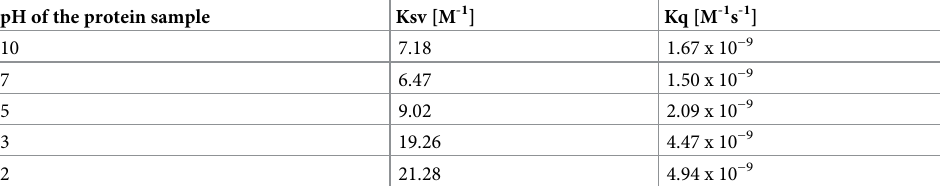
Table 2. Fluorescence quenching of Sus1 in presence of acrylamide at different pH states. The ratio of FI in the absence and presence of acrylamide at different concentration was plotted with the acrylamide concentration. Using this plot the Ksv and Kq were